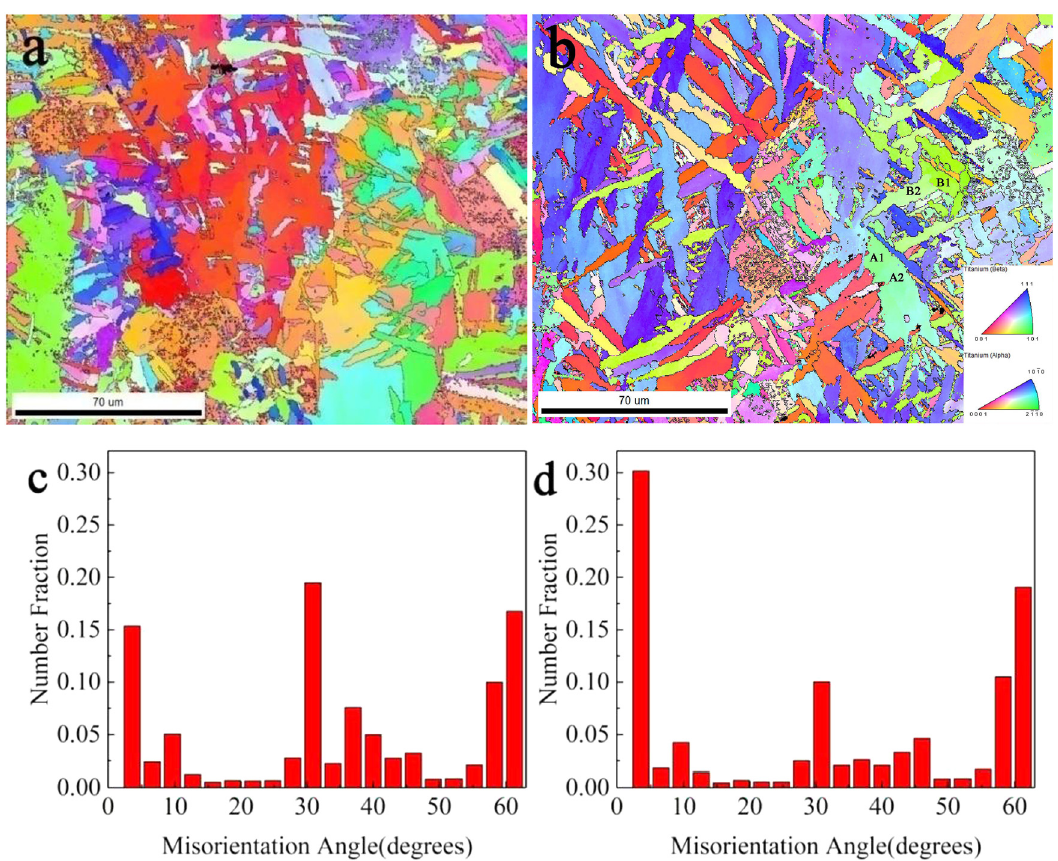
Figure 8: Inverse pole fi gure of the samples at the deformation of two - pass: ( a ) 1 s − 1 ; ( b ) 5 s − 1 , misorientation angles of the samples at the deformation of two - pass; ( c ) 1 s − 1 ; and ( d ) 5 s − 1